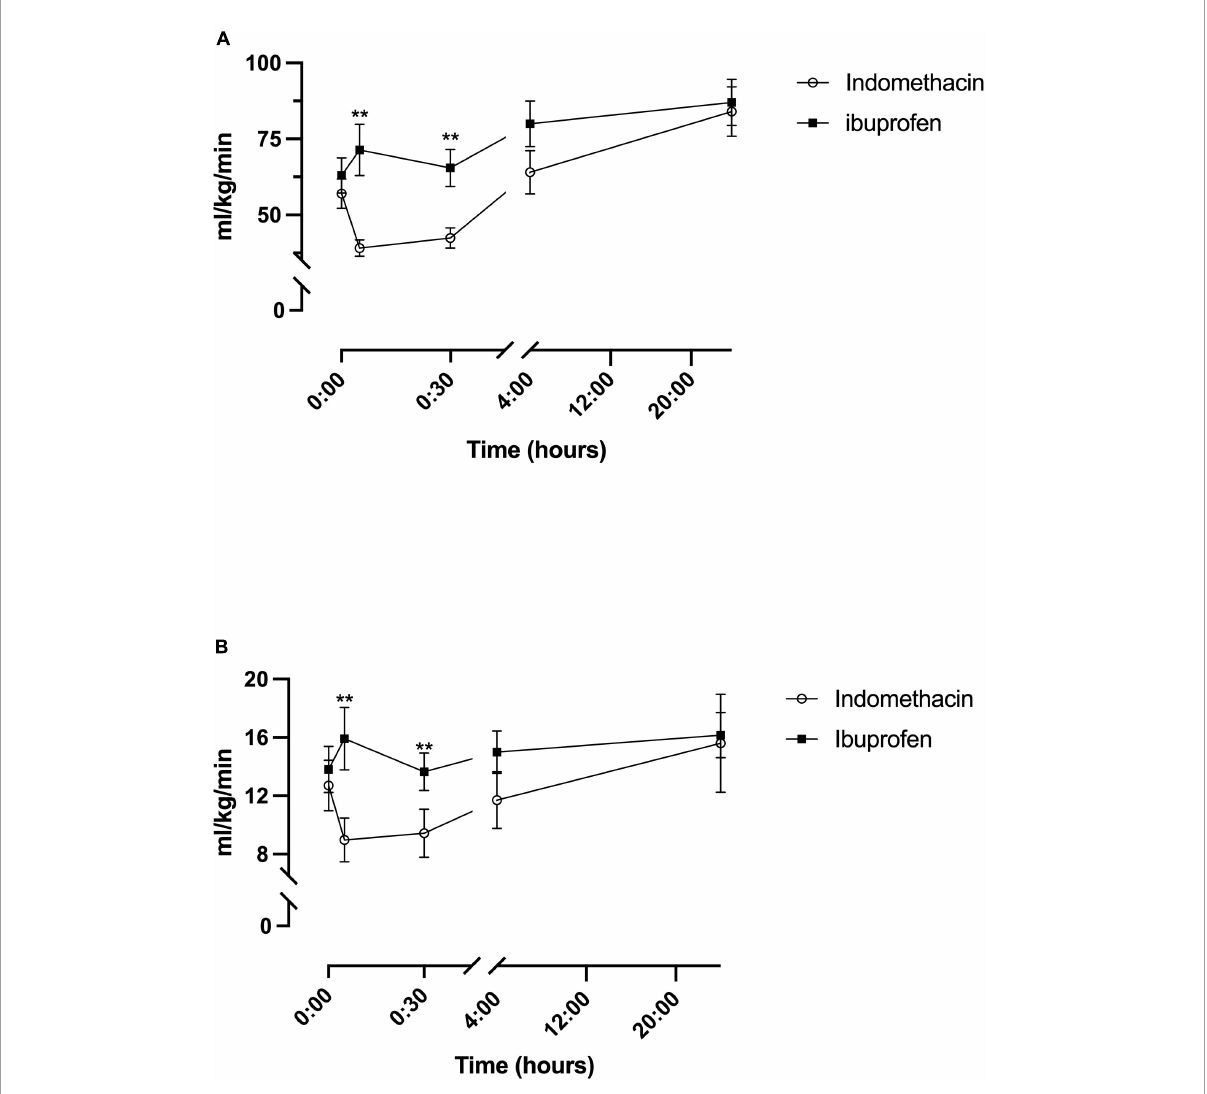
FIGURE2 Temporal changes in oxygen delivery for the indomethacin and ibuprofen treatment groups. (A) Total internal carotid blood flow. (B) modCerbDO 2 . ** p < 0.01 between treatment group difference at that study